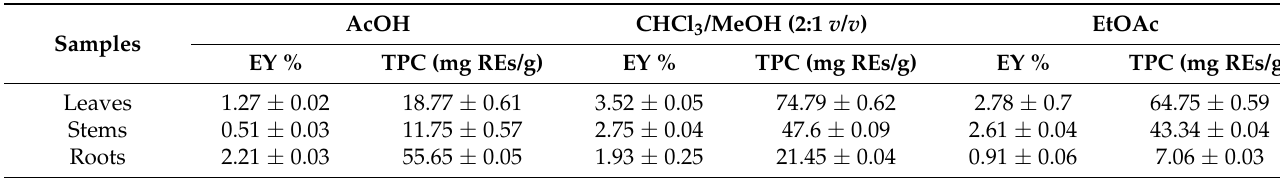
Table 1. Effect of different solvents on EY and TPC for SRLe .